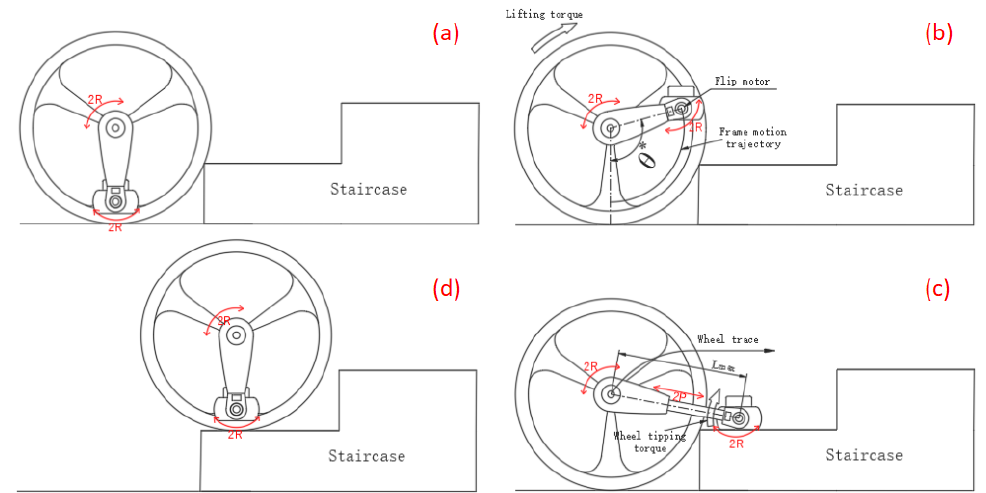
Figure 2. Gait diagram of climbing stairs by “approaching, lifting, putting and retraction”: ( a ) the robot approaches stairs; ( b ) the cantilever lifts the frame; ( c ) the robot extends its cantilever and sets its frame on the stairs; ( d ) the robot’s wheels are lifted onto the steps of the frame and the robot enters into an “approaching” gait again.